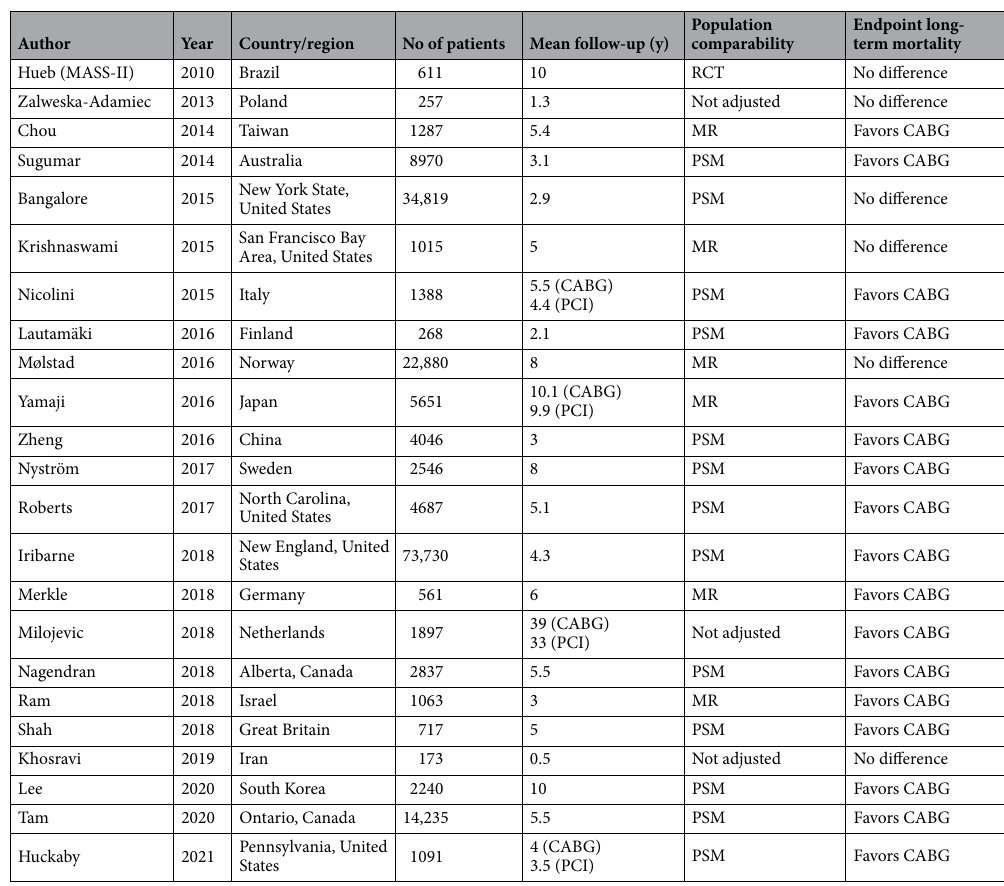
Table 1. Summary of included studies (references are reported in the Supplementary Material). CABG coronary artery bypass grafting, MR multivariable regression, PCI percutaneous coronary intervention, PSM propensity score matching, RCT randomized clinical